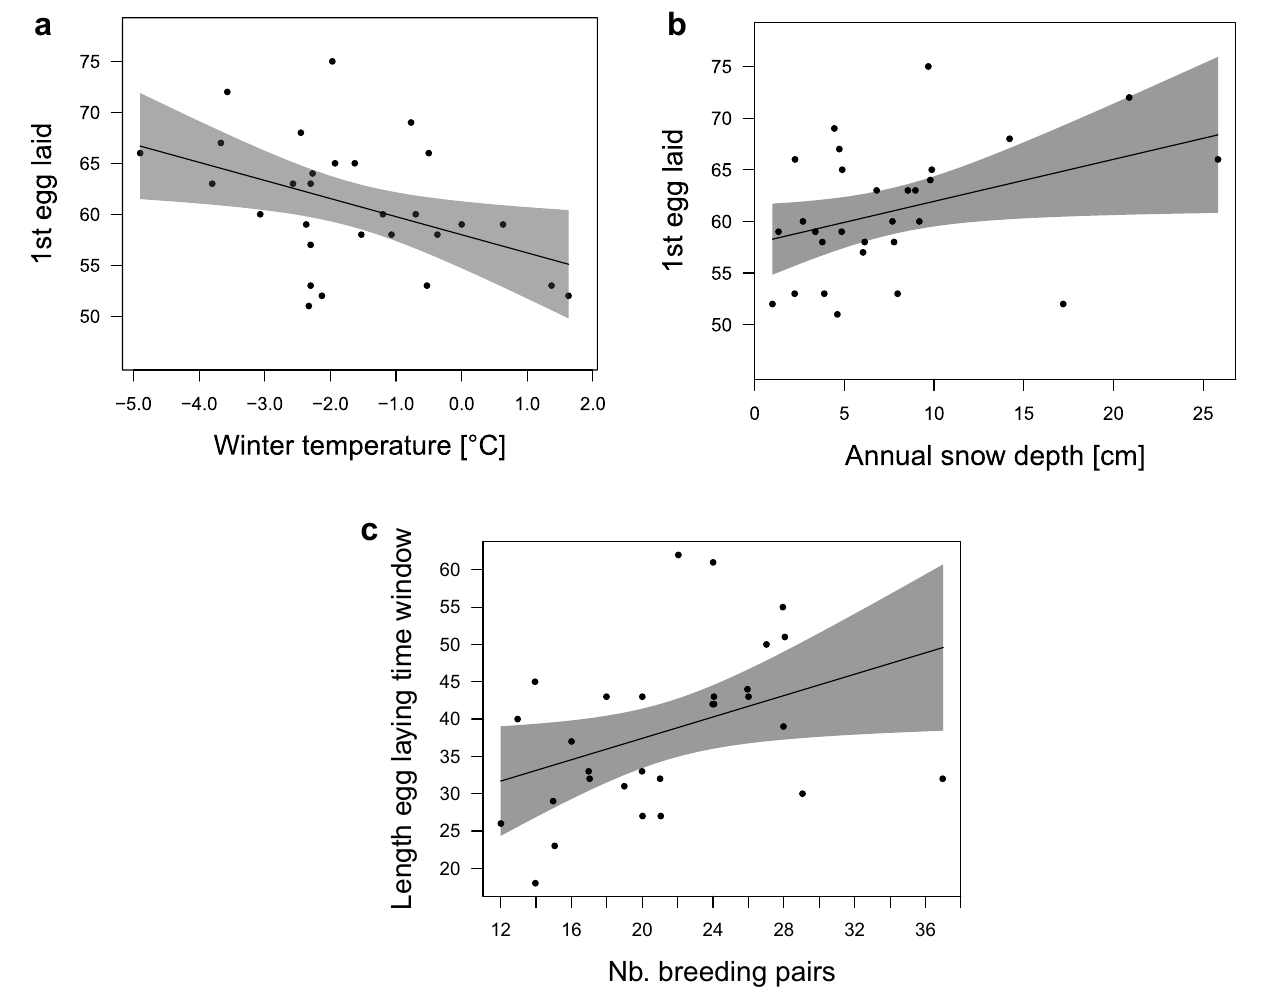
Figure 3. Relationship between the first egg laid within the flock and ( a ) average winter temperature (estimate − 0.43 ± 0.25 SE, − 0.788 LCI − 0.075 UCI); and, ( b ) annual snow depth (estimate 0.38 ± 0.18 SE, 0.010 LCI 0.742 UCI). ( c ) Relationship between the length of the egg-laying time window and the number of breeding pairs of the flock (estimate 0.72 ± 0.33 SE, 0.048 LCI 1.384 UCI) in greylag geese in the Alm valley, Austria, between 1990 and 2018. Lines are the predicted relationship based on model results (Table 1) with 95% CIs in shaded grey. Background scatter represents raw